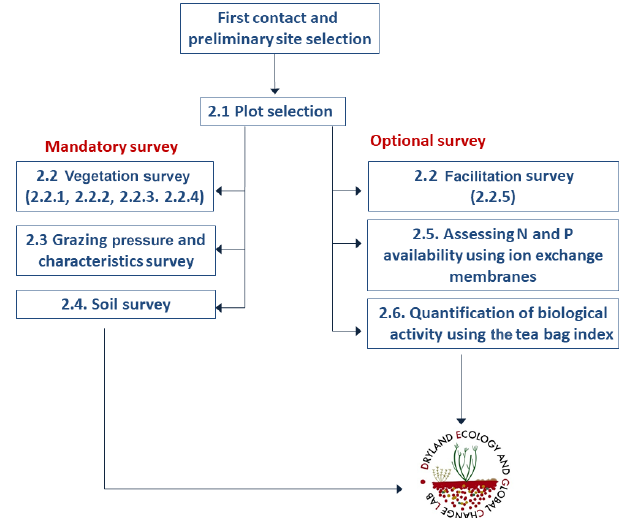
Figure 1. Flowchart of the actions and measurements involved in the BIODESERT survey. The numbers indicate the sections of the article where each part of the survey is described. N = nitrogen and P =